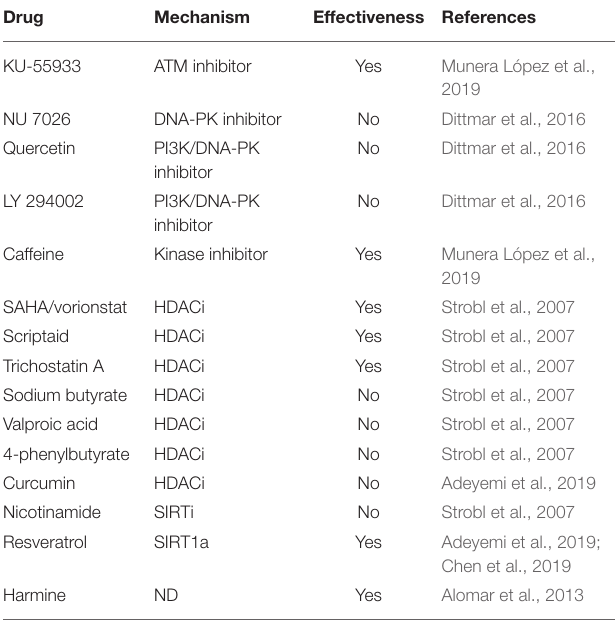
TABLE 3 | HRR inhibitors used in T. gondii models.